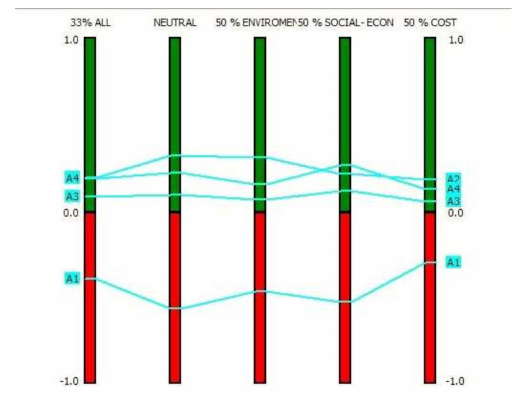
Figure 15. Result comparison of the five possible decisions for the Mikro Derio